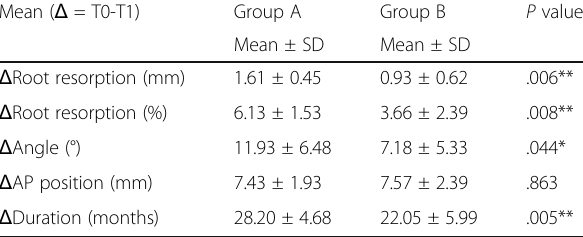
Table 2 Comparison of the change between two